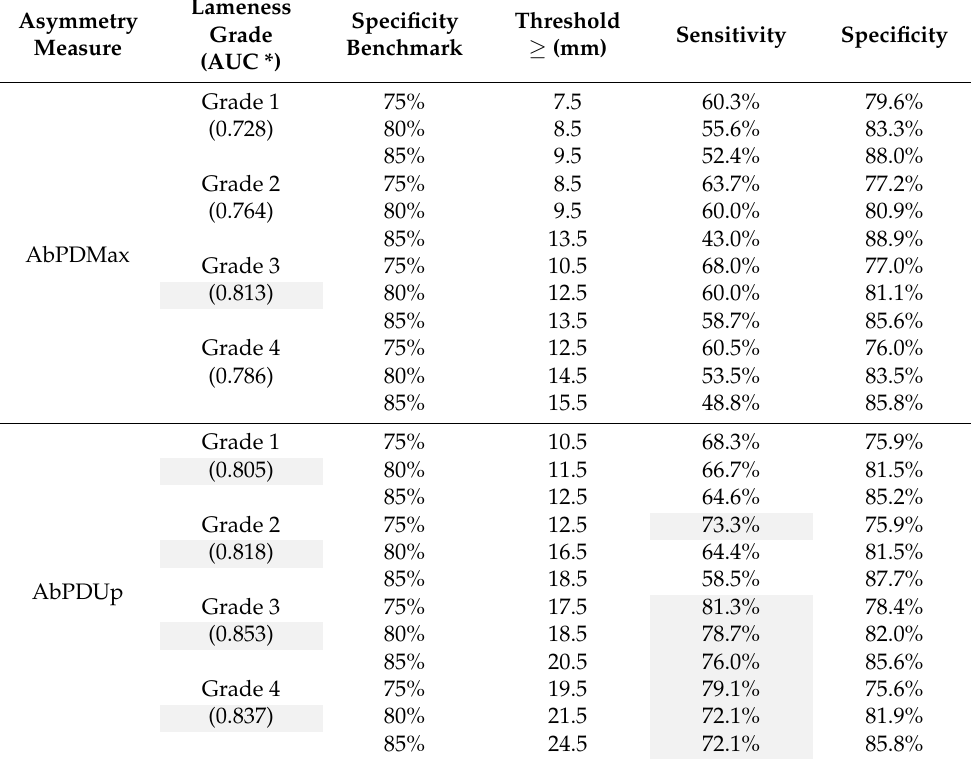
Table 2. Cont. Asymmetry